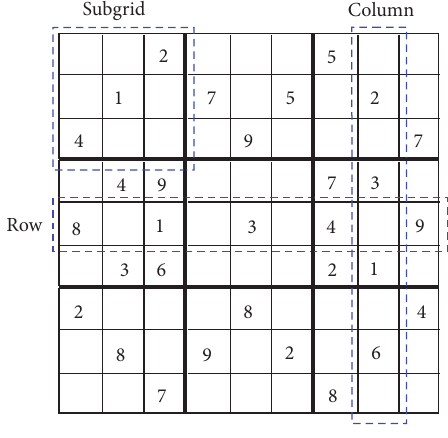
Figure 1: Sudoku puzzle